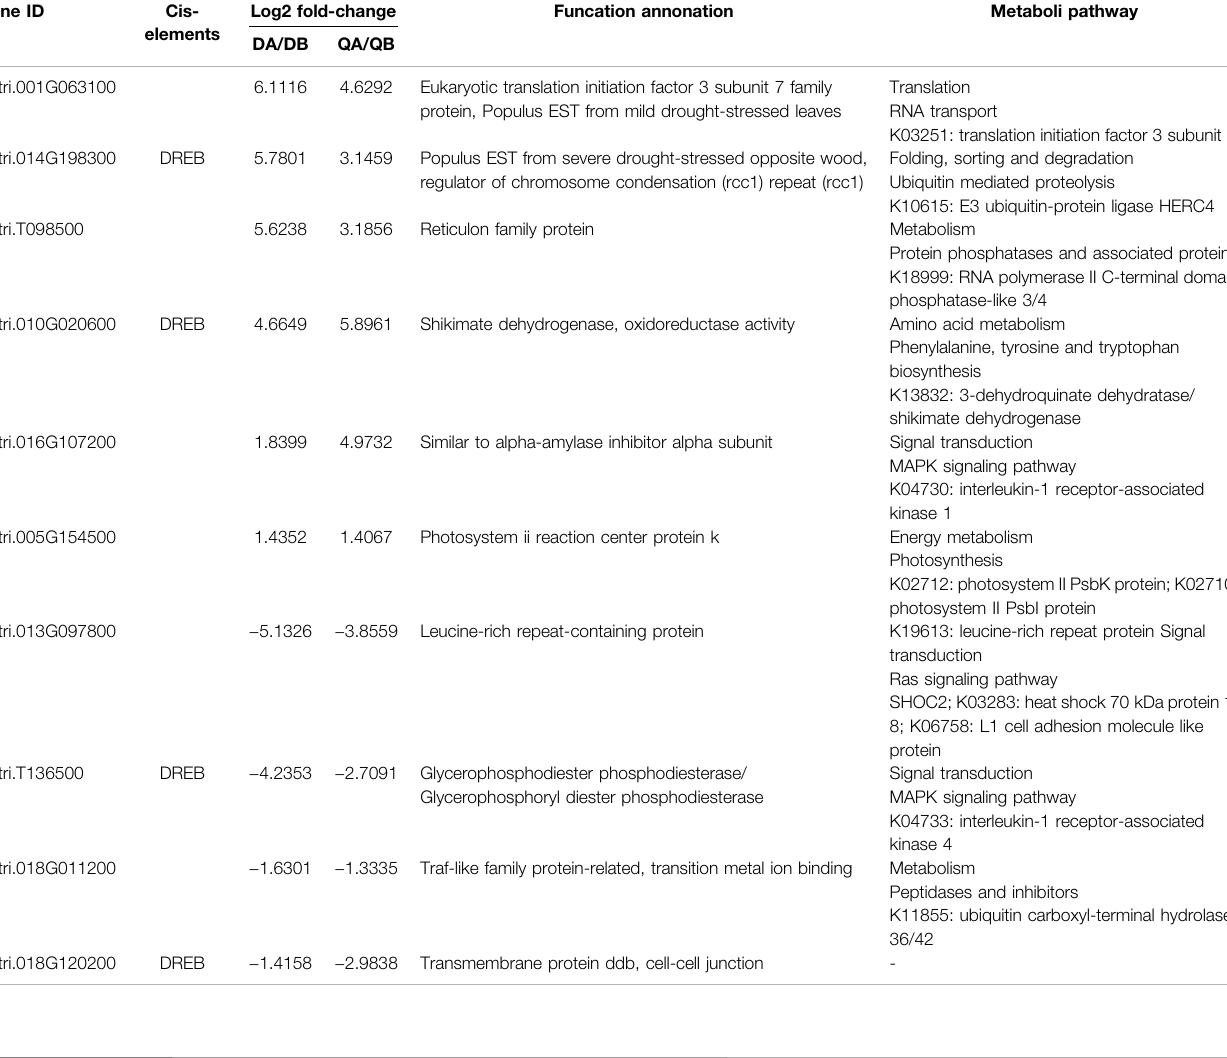
TABLE 2 | Analysis of DGEs induced by the introduction of the JERF36 gene.